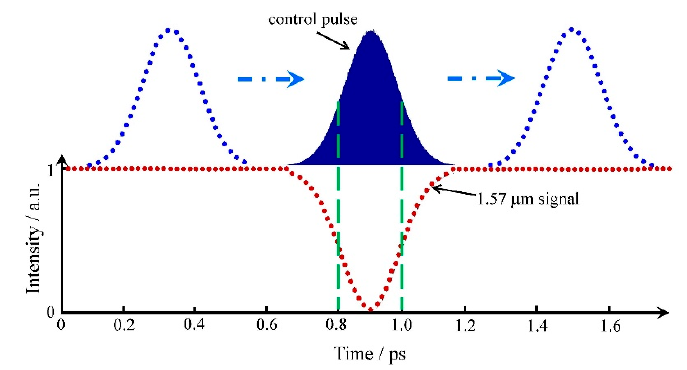
Figure 6. Schematic diagram of the all-optical signal modulation controlled by the ultrafast single pulse.